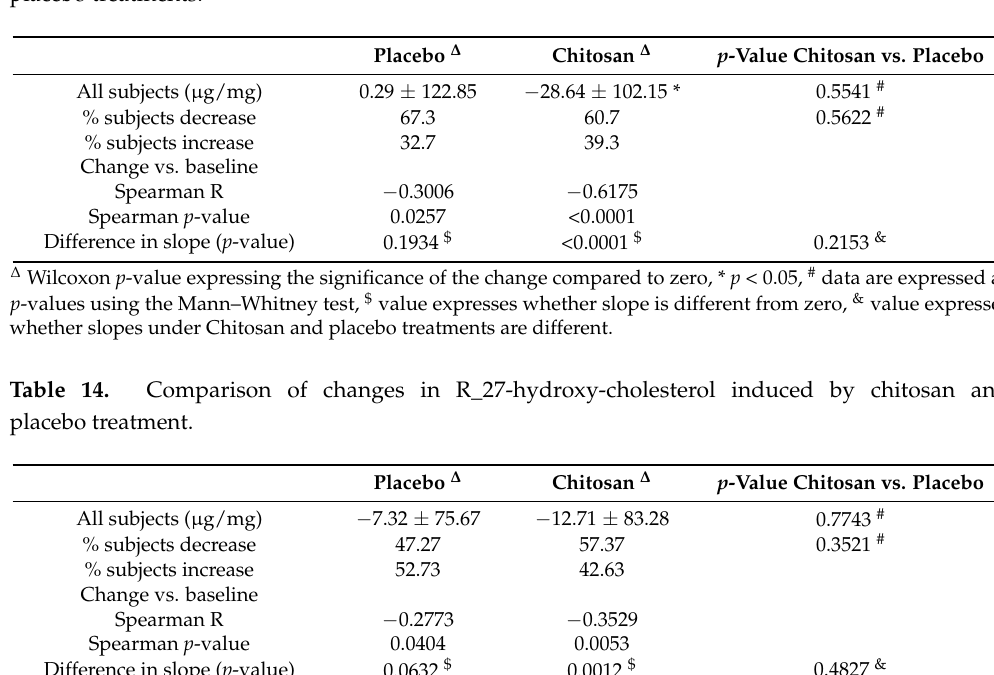
Comparison of changes in R_7 α -hydroxy-cholesterol induced by chitosan and placebo treatments.